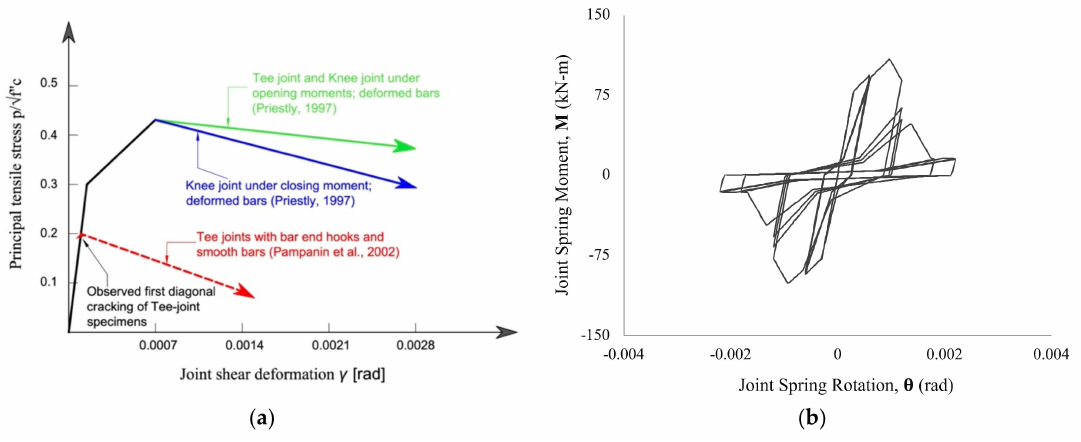
Figure 6. ( a ) Joint shear strength degradation model for exterior and corner joints [27,36]. ( b ) Hysteretic rule used to model joint stiffness and strength